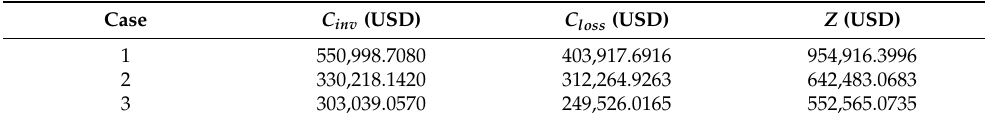
Table 17. Investment and operating costs found with the application of the MGbMO to the three- phase version of the IEEE 85-bus grid for each operative